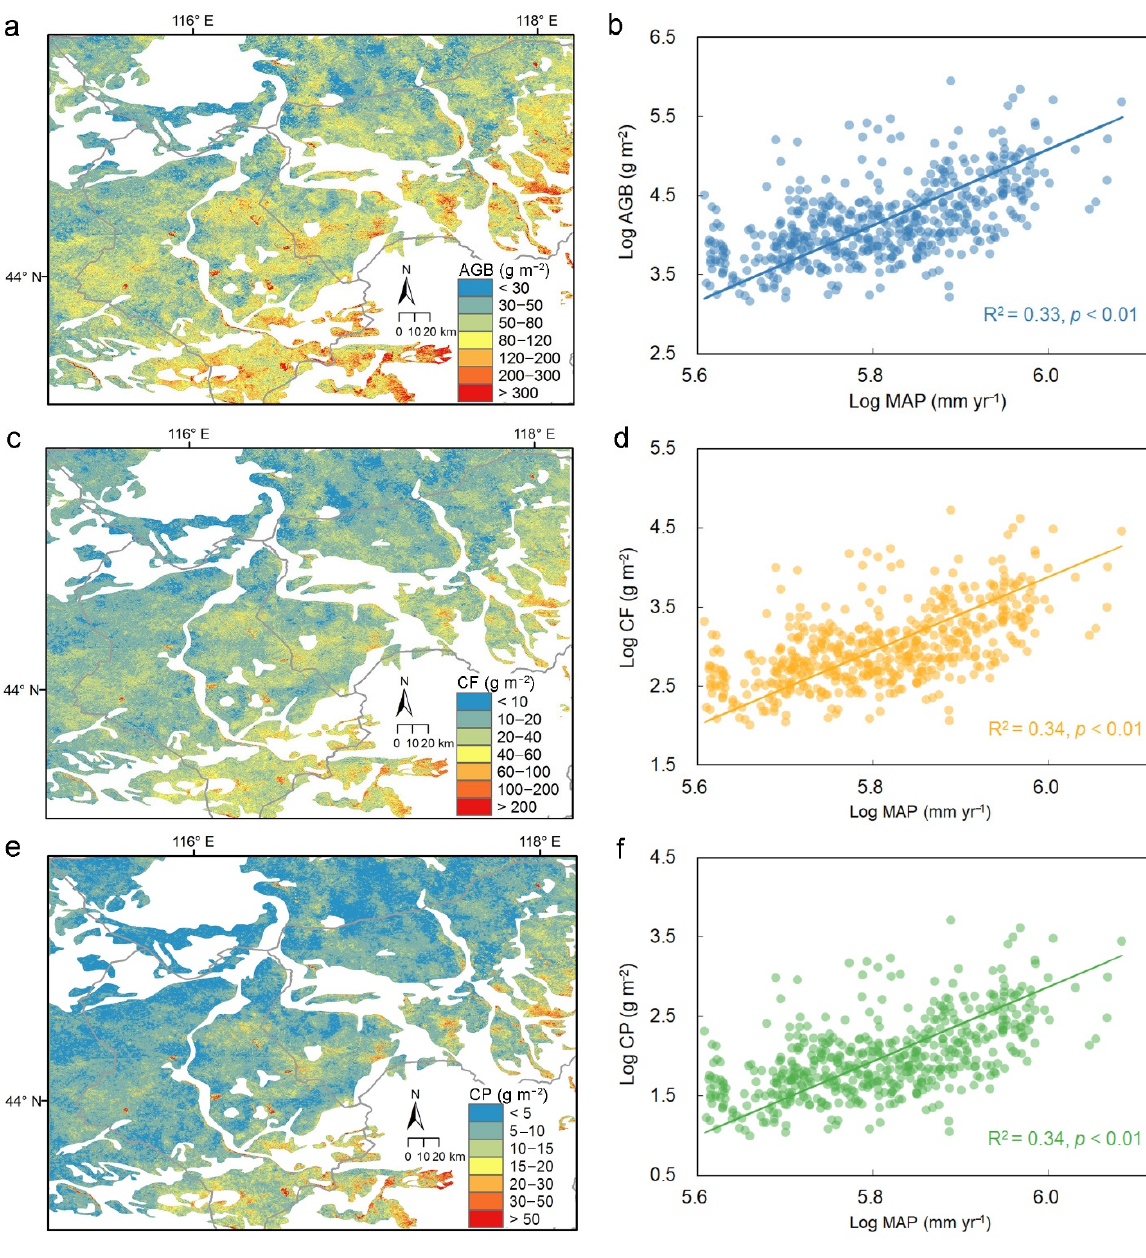
Figure 6. Spatial patterns of predicted forage biomass ( a ), crude fiber ( c ), and crude protein ( e ) per area and their correlations with MAP ( b , d , f ).